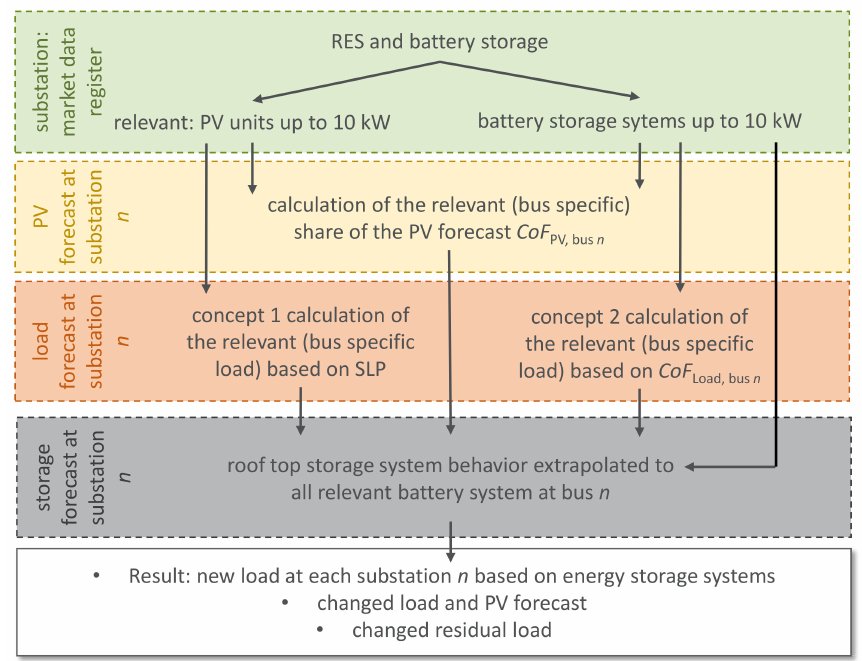
Figure 3. Concept for substation-specific storage